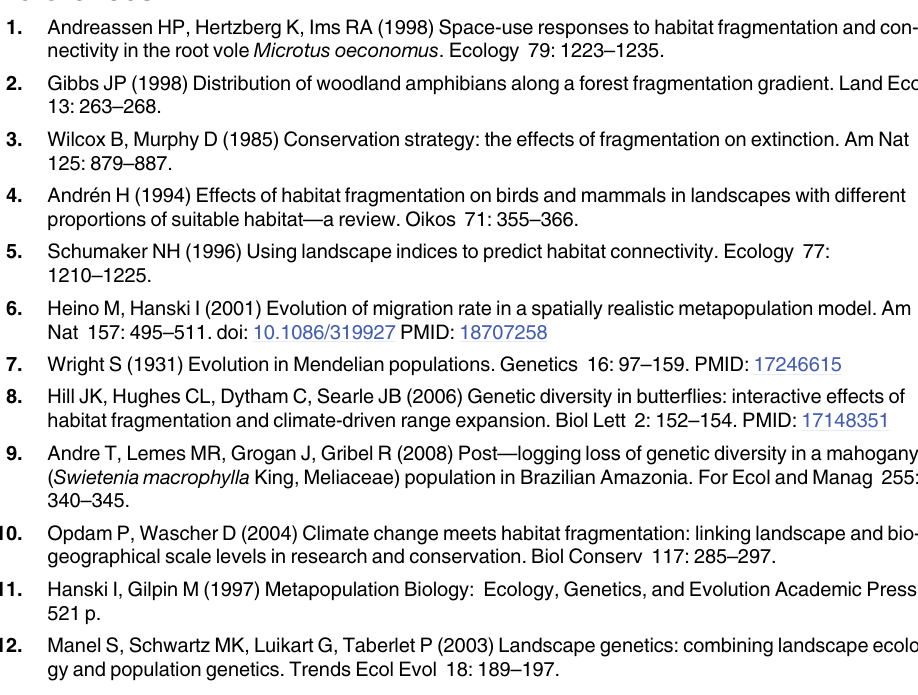
S1 Fig. Plot of Euclidean distance versus F